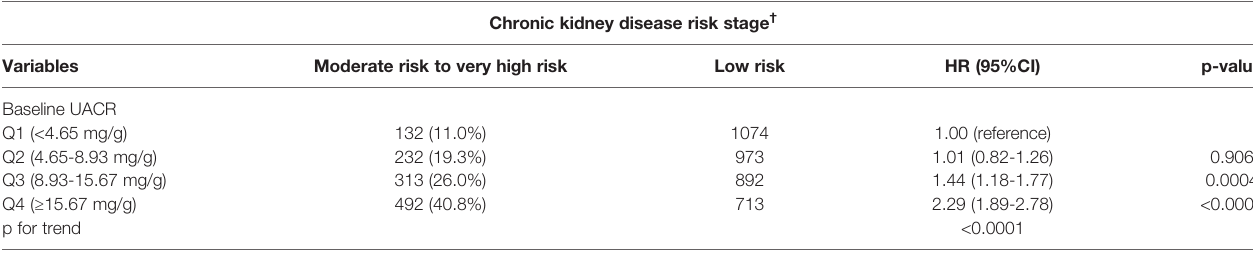
TABLE 1 | Hazard ratios (HRs) of chronic kidney disease risk progression according to baseline urinary albumin/creatinine ratio quartiles followed for a mean 4.9 ± 4.0 years (N=4821). Chronic kidney disease risk stage † Variables Moderate risk to very high